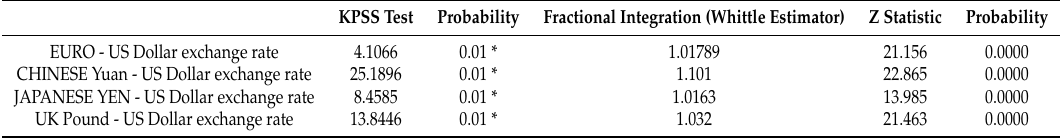
Table 1. Tests of Stationarity